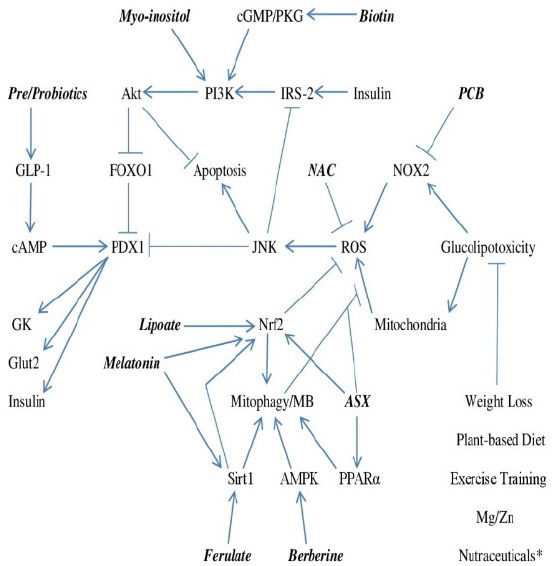
Figure 1. Regulation of GSIS and Apoptosis in Beta Cells Exposed to Glucolipotoxicity–and How Nutraceuticals and Lifestyle May Support Effective Beta Cell Function and Survival. * Nutraceuticals including berberine, myo-inositol, biotin, PCB, cinnamon extract and chromium may diminish beta cell exposure to glucose and free fatty acids by aiding peripheral insulin sensitivity or decreasing hepatic glucose